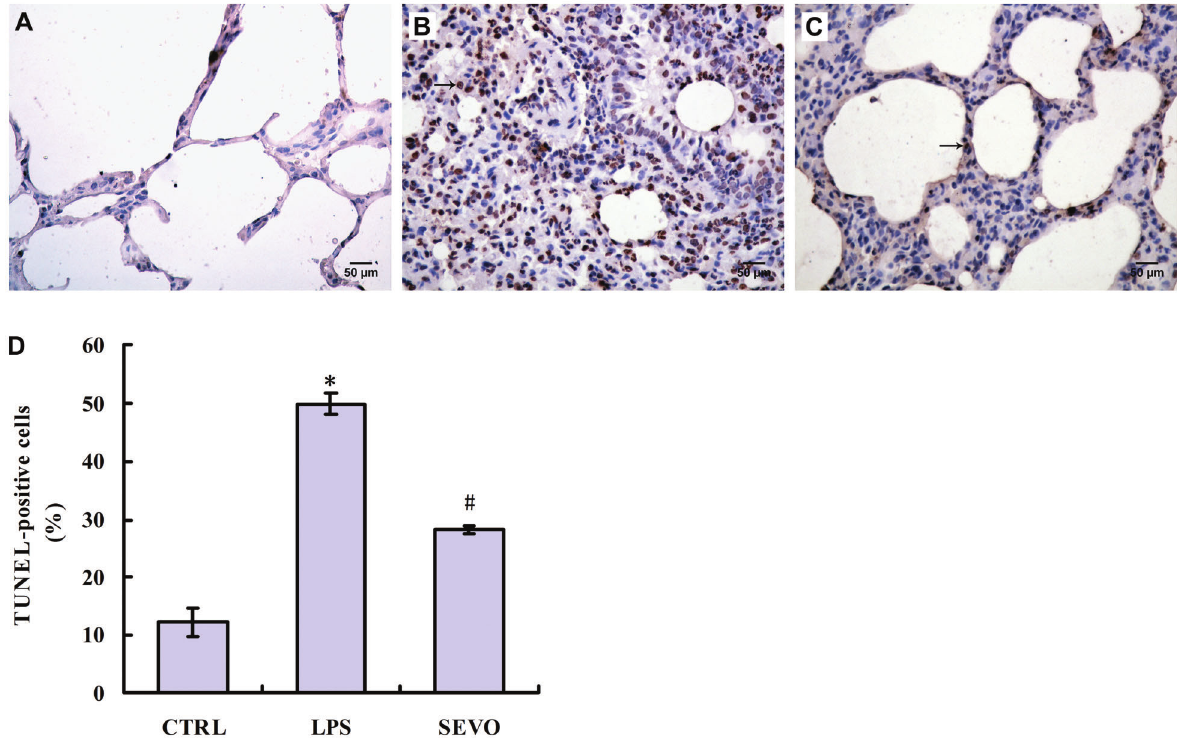
Figure 4. Apoptotic index (AI) in lung tissue samples. Data are reported as means ± SD (n=6 per group). TUNEL assay results showing apoptosis (magni fi cation, 400 (cid:1) ) in the CTRL group ( A ), LPS group ( B ), and SEVO group ( C ). D , Relative AI values in the lung. CTRL: control group injected intratracheally with normal saline; LPS: injected intratracheally with lipopolysaccharide; SEVO: injected with LPS plus inhaled sevo fl urane for 30 min. *P o 0.01 vs CTRL group, # P o 0.01 vs LPS group